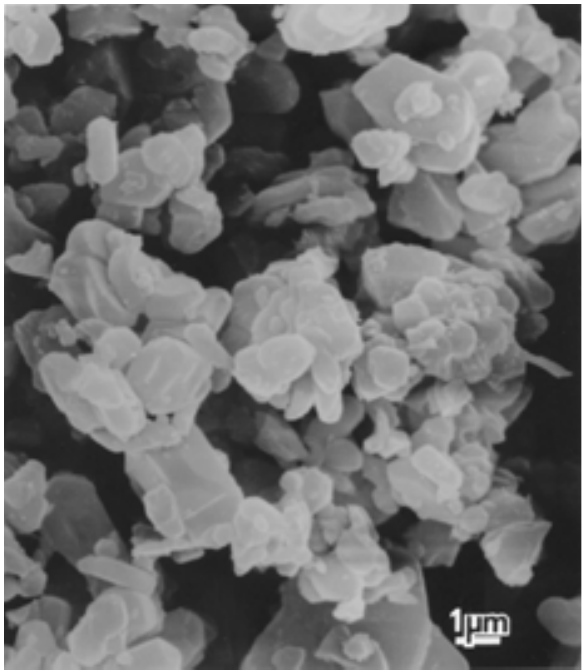
Figure 10. Scanning electron micrograph of ALCOA 2011 α -Al 2 0 3 . Figure 9. Transmission electron micrograph ofalpha-Al 2 0 3 from fibrillar